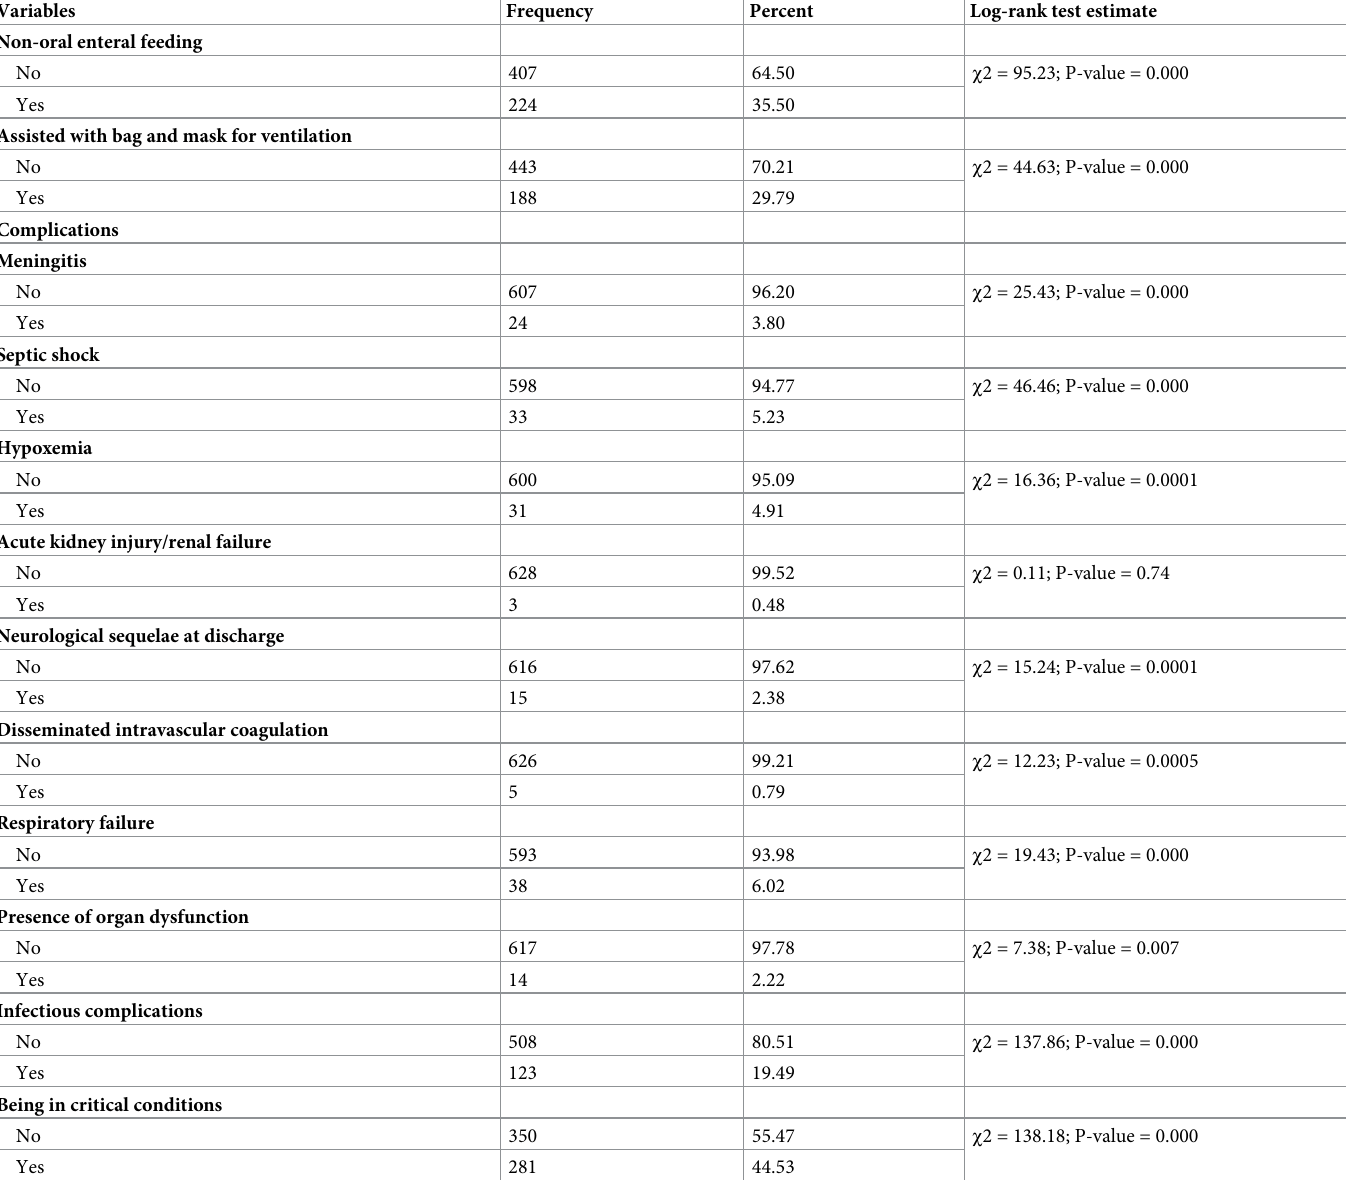
Table 6. Management and complication-related characteristics in Public Hospitals of Central Gondar Zone, 2021 (n = 631).